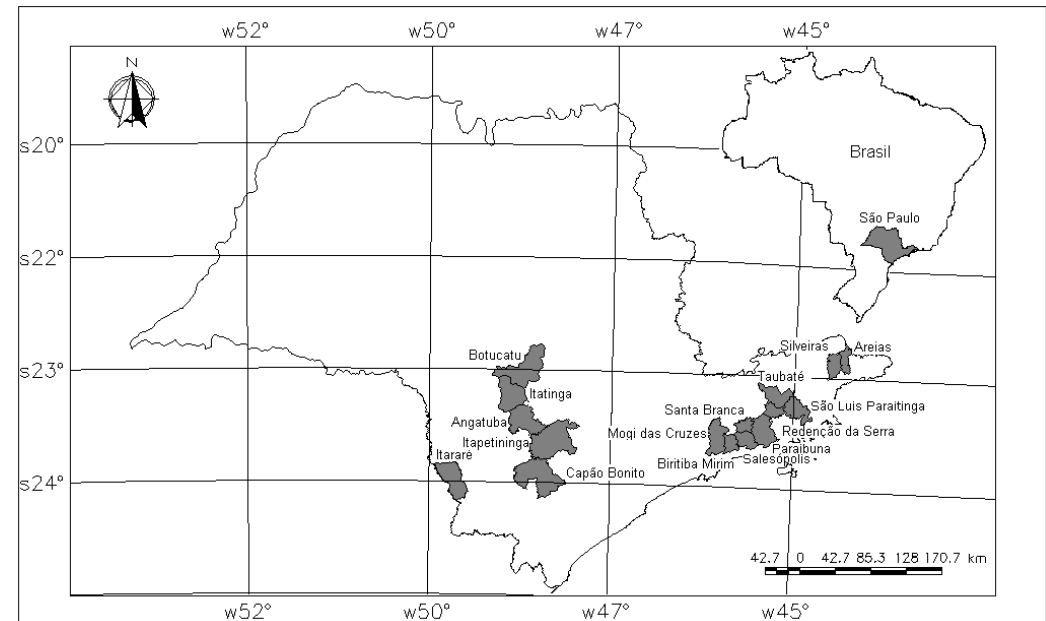
Figure 1. Location of study areas in the state of São